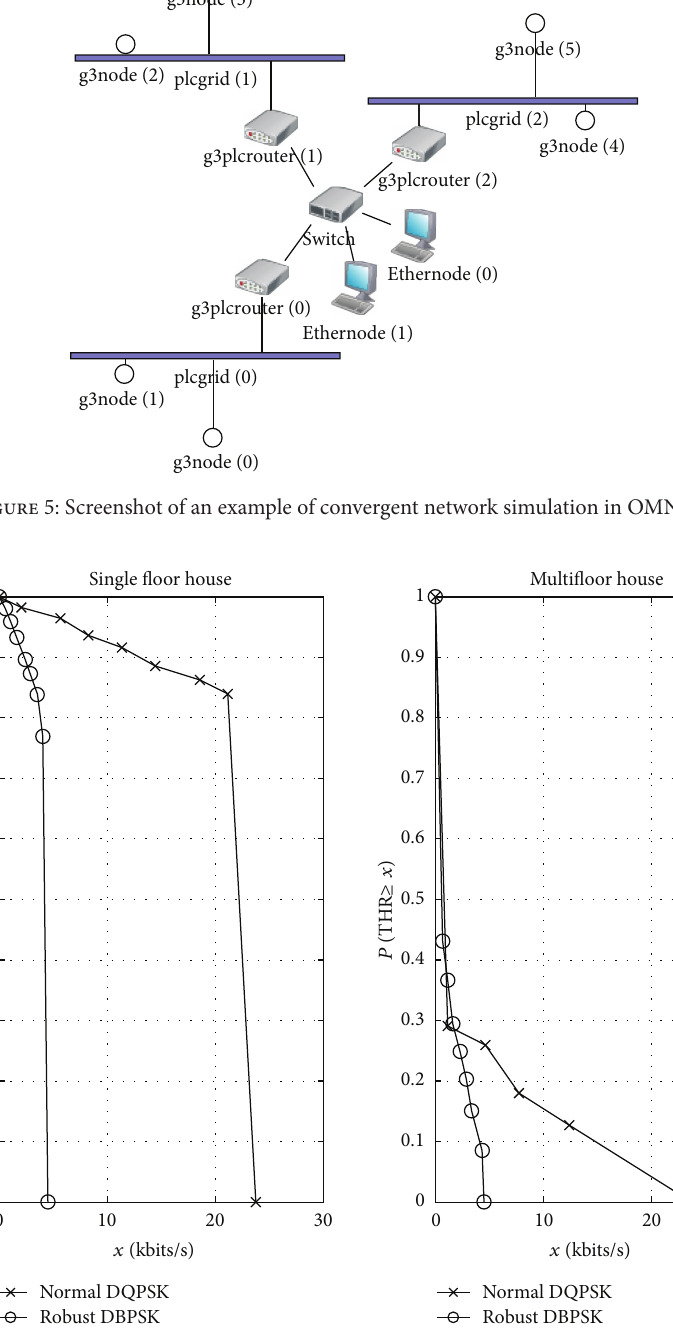
F 6: CCDF of the measured THR for G3-PLC